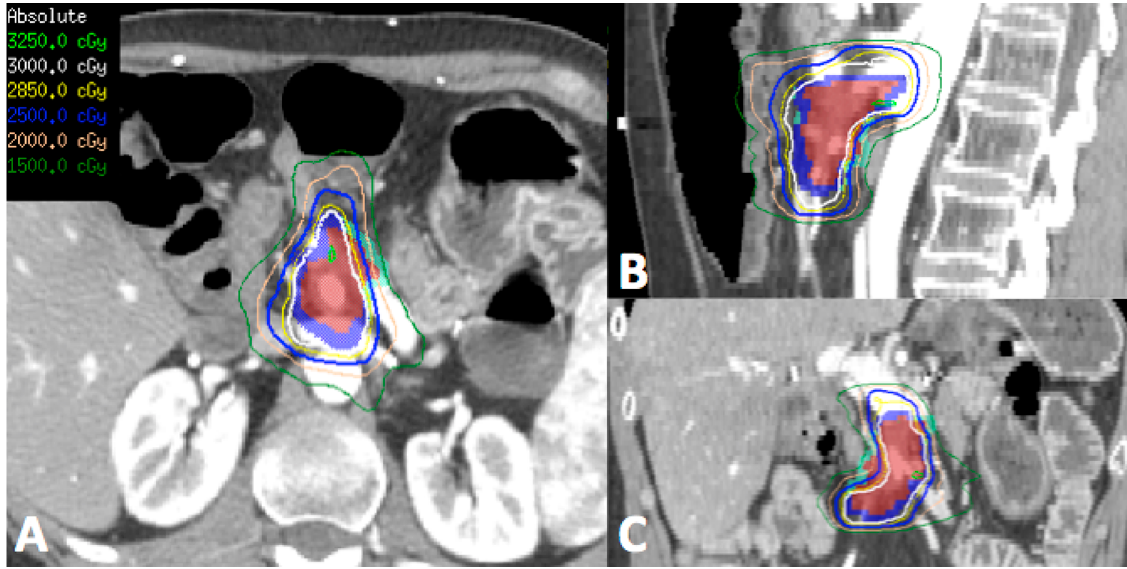
Figure 1. Representative transverse ( A ), sagittal ( B ) and coronal ( C ) images of the reirradiation treatment plan using stereotactic body radiotherapy (SBRT) for a patient who had previous 3D conformal radiotherapy to the region 5 years ago to 50.4 Gy in 28 fractions. (Red—gross tumor volume, Dark blue—target for 30 Gy, Light blue—target for 25 Gy due to proximity to surrounding bowel and stomach). Patient tolerated treatment well with Grade 1 nausea and was alive 12 months post ‐ treatment with no significant late toxicity.